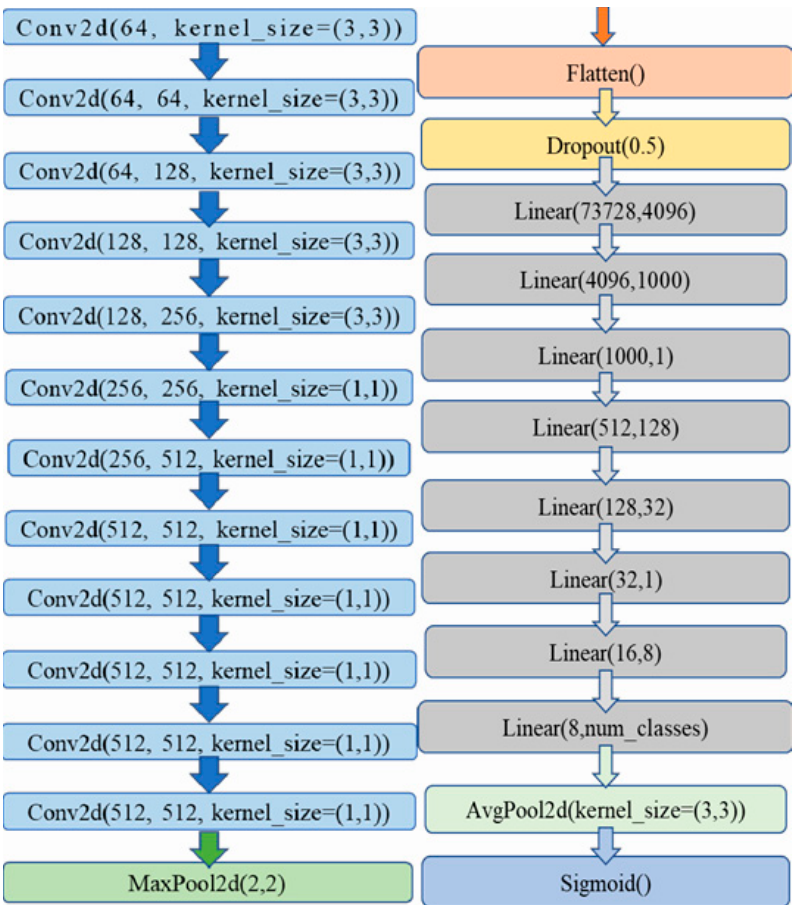
Figure 4. The generic CNN model was used for this